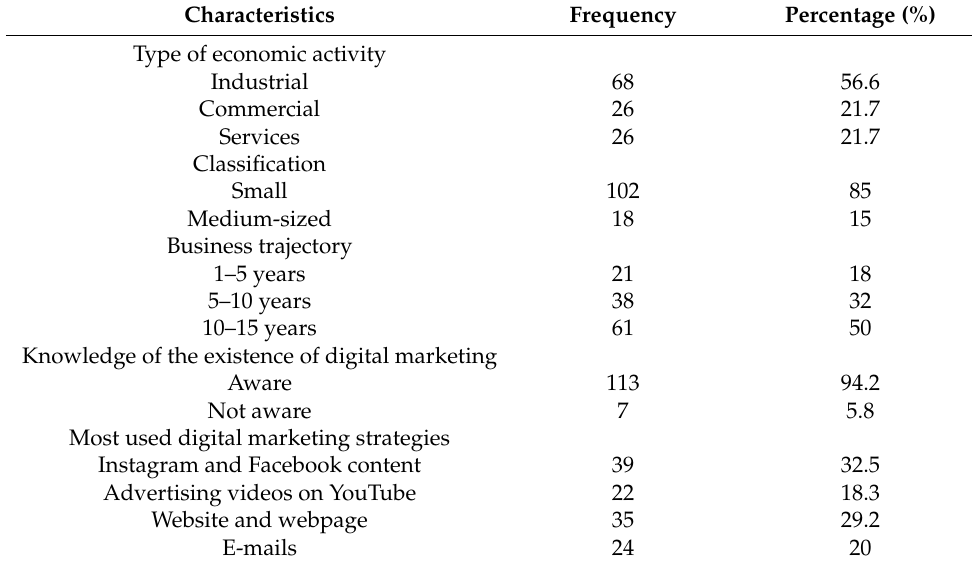
Table 1. Demographic characteristics of the